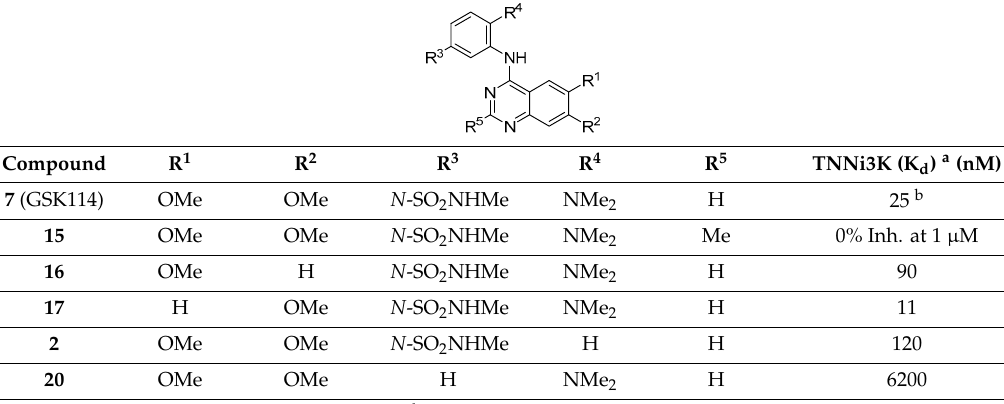
Table 1. Results of 4-anilinoquinazolines 2 , 7 , 15–17 & 20 in the TNNi3K binding assay.